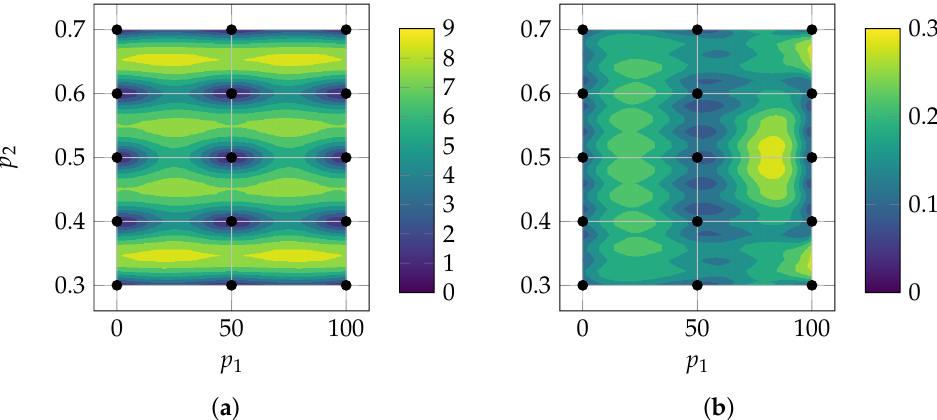
Figure 9. L 2 prediction errors in the parameter space reconstruction for p d = ON. Samples of oPODs are marked with .